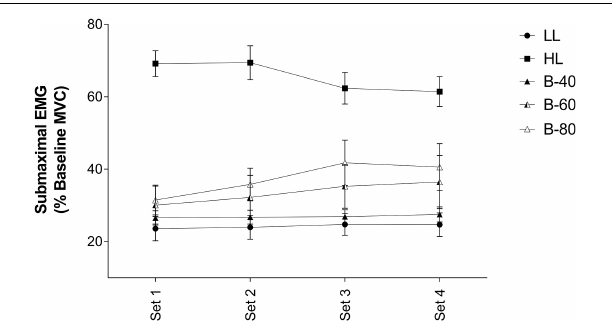
FIGURE 3 | Electromyography (EMG) of submaximal contractions in the Vastus Lateralis muscle during all five trials [heavy load (HL), light load (LL), 40% limb occlusion pressure (B-40), 60% limb occlusion pressure (B-60), 80% limb occlusion pressure (B-80)]. Values are presented as mean ± SEM. Significance set at p < 0.05.